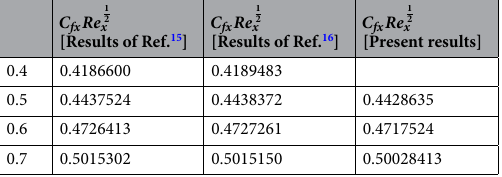
Table 4. Comparison of the present work with the published work 15,16 .